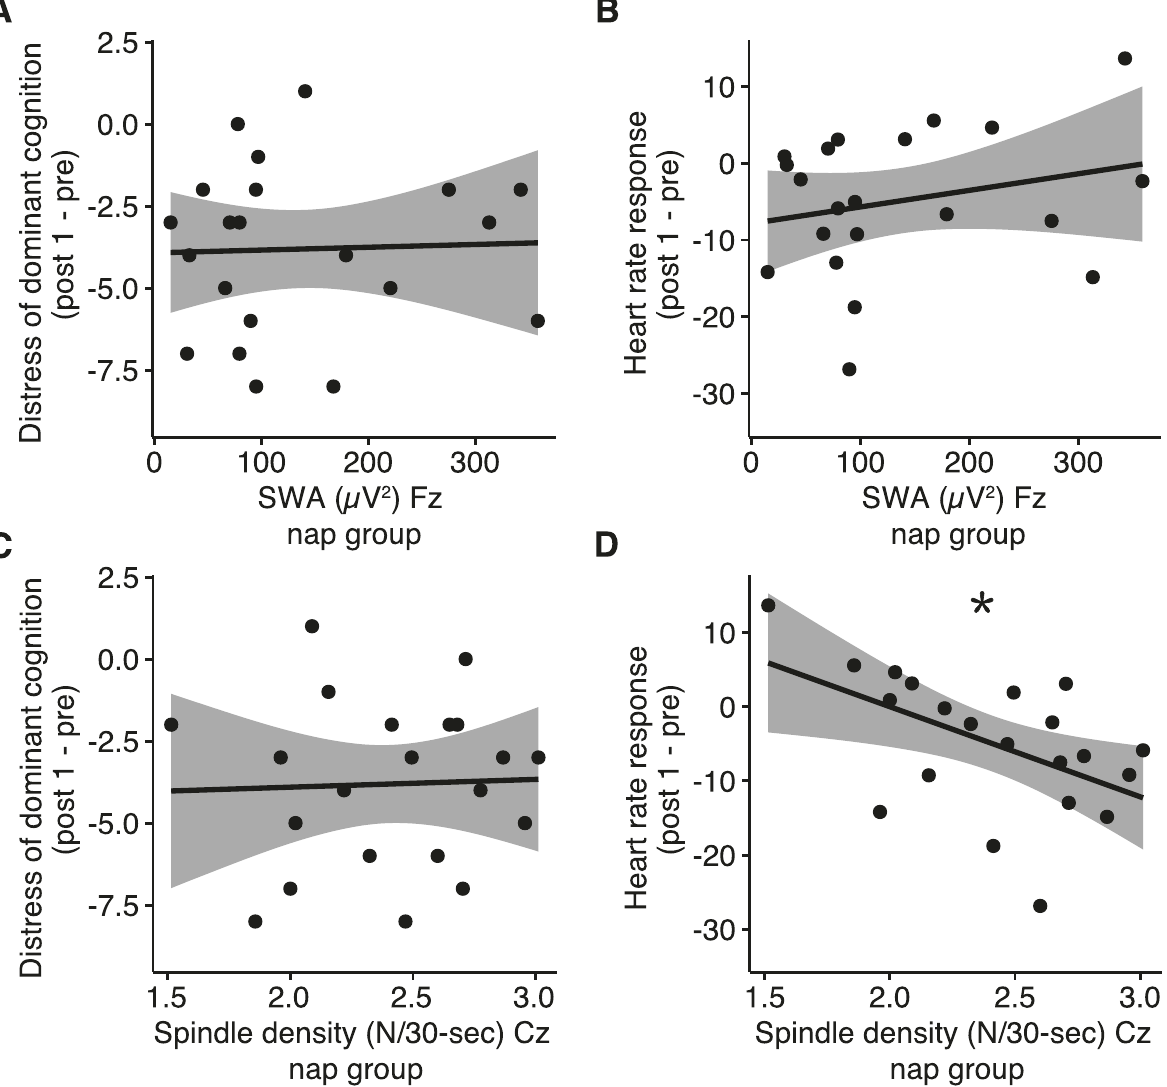
Fig. 4 Correlation between sleep indices and reduction of arousal and distress. Scatter plots illustrating the correlation between sleep physiology (SWA and fast spindle density) and reduction of distress associated with the aversive memory ( A , C ) and arousal measured by HR ( B , D ) from pre to post. The 1.95% con fi dence intervals are depicted in grey. * p < 0.05. SWA = slow wave activity (measured at Fz in the spectral band 0.5 – 4 Hz); fast sleep spindles (13 – 15 Hz) were measured at Cz and automatically detected during stage N2 and